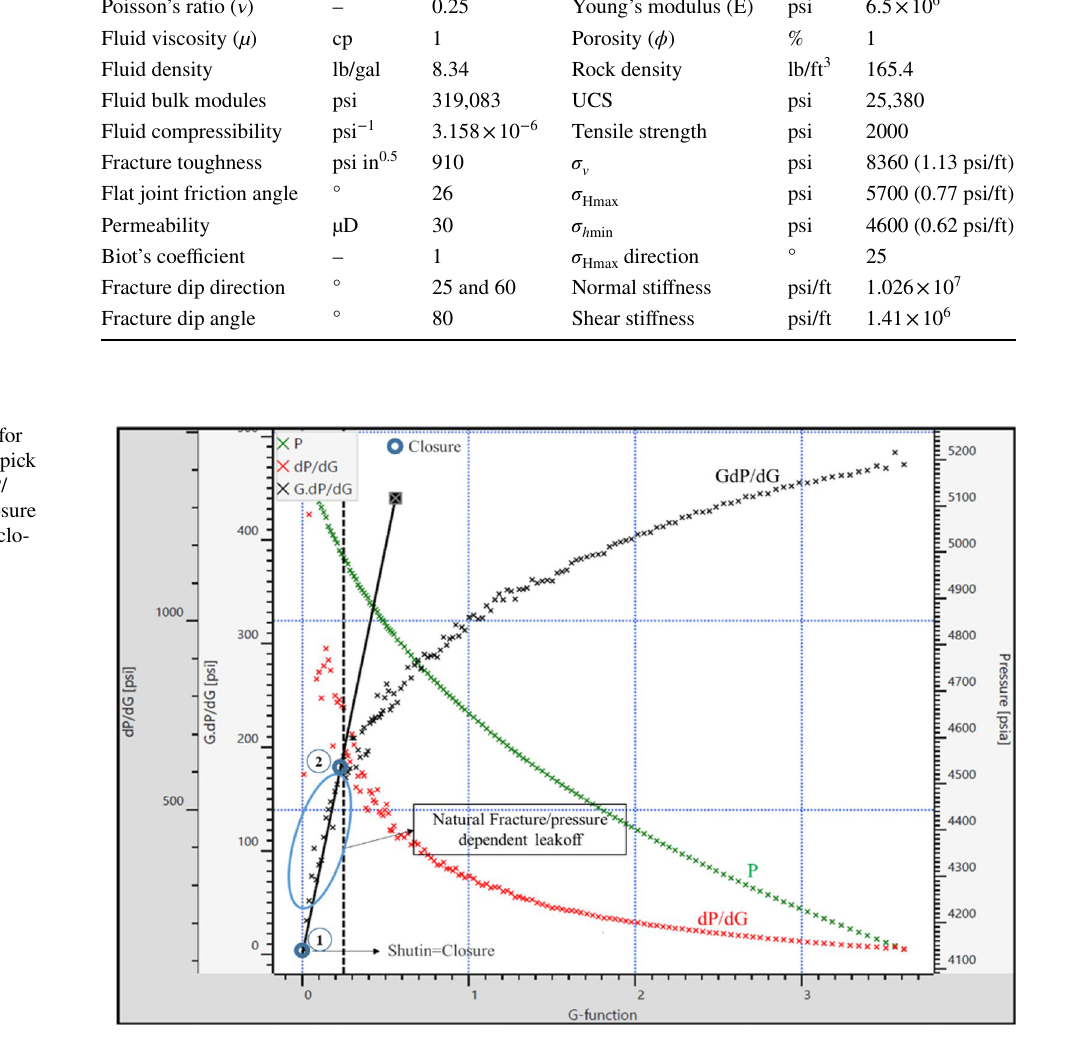
Table 2 Base settings used in the all numerical simulations